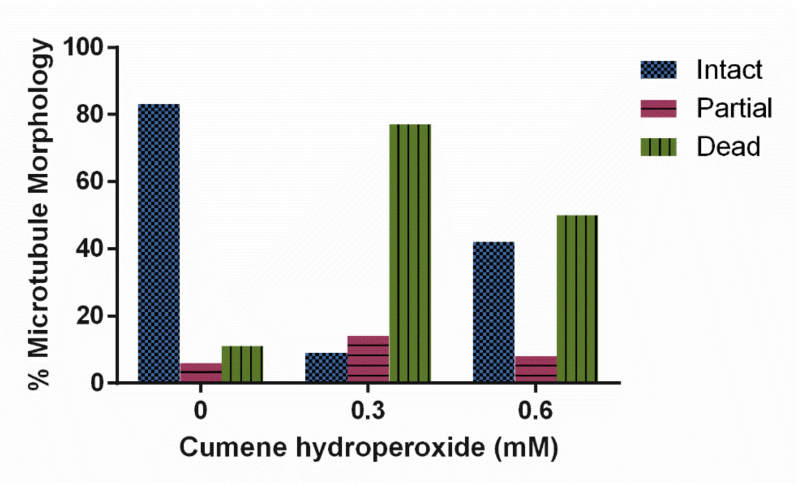
Figure 3. Effect of cumene hydroperoxide on microtubule morphology in D. discoideum. Cumene significantly decreased microtubule stability (n > 50 cells, p <